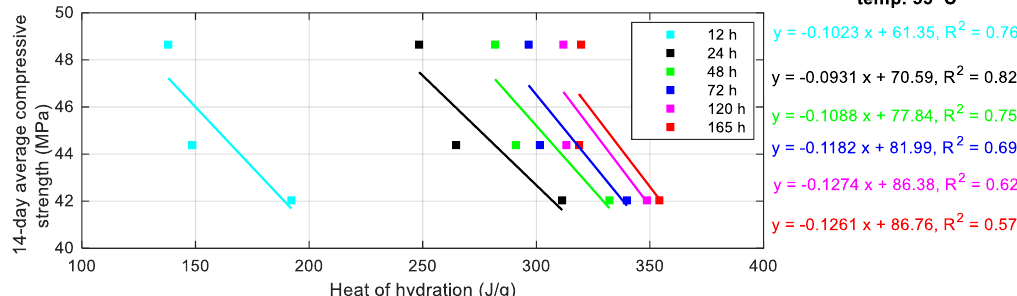
Figure 11. Correlation of 14-day strength and heat of mortars cured at 53 °C.